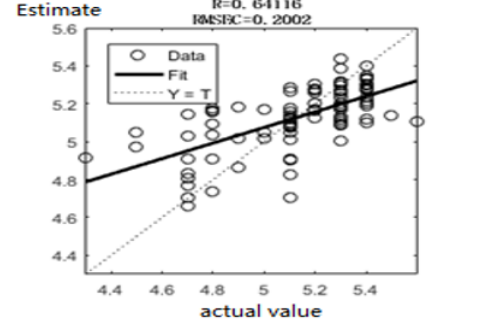
Fig. 5. SNV+ principal component analysismethod is to establish the correlation image between the predicted value and the actual value of soluble solids